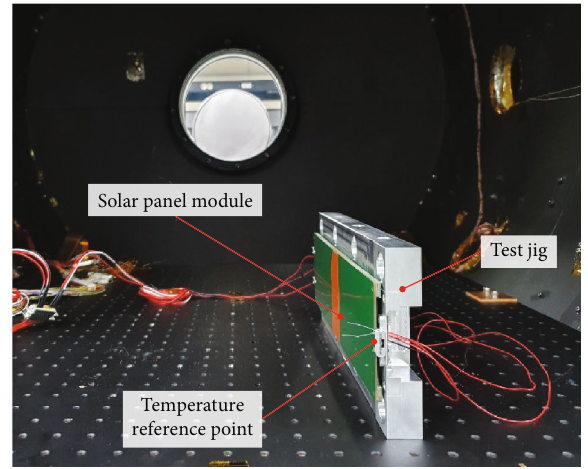
Figure 13: TV test setup con fi guration of the solar panel